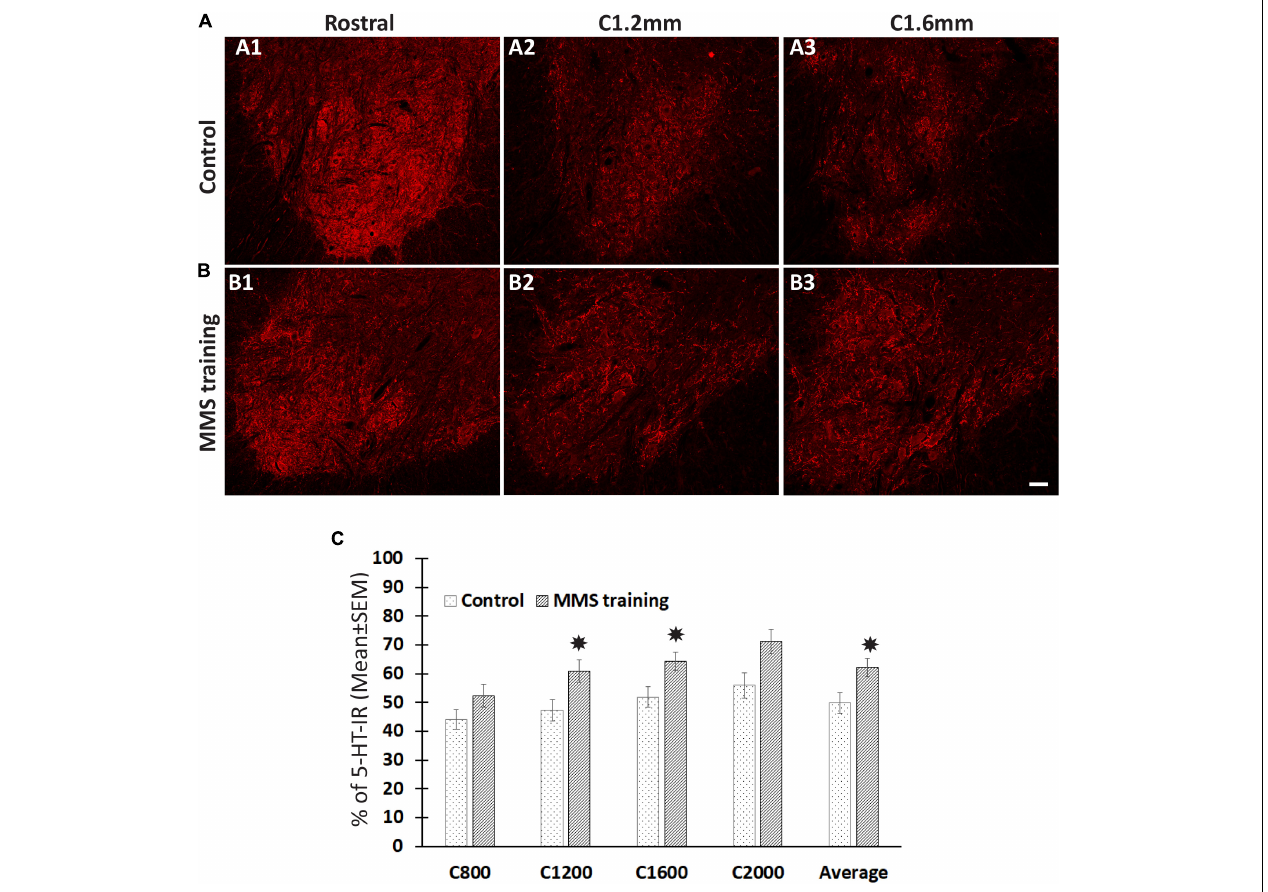
FIGURE 3 | Sprouting of serotonergic axons after Modified Montoya Staircase (MMS) rehabilitation. Representative images of 5-hydroxytryptamine (5-HT)-immunoreactive (IR) fibers in the cervical ventral horns 4 mm rostral, 1.2 and 1.6 mm caudal to the injury epicenter were taken in rat without rehabilitation (A1–A3) or with MMS rehabilitation (B1–B3) . The quantification showed that MMS rehabilitation significantly increased the amount of 5-HT-IR fibers in ventral horns 1.2 and 1.6 mm caudal to the epicenter and the average from 0.8 to 2 mm caudal to the injury [ (C) , p = 0.042, 0.032, and 0.039, respectively]. Results in (C) represent mean ± standard error of the mean (SEM); n = 5 in each group. Scale bar = 50 µ m (A,B) . * P <